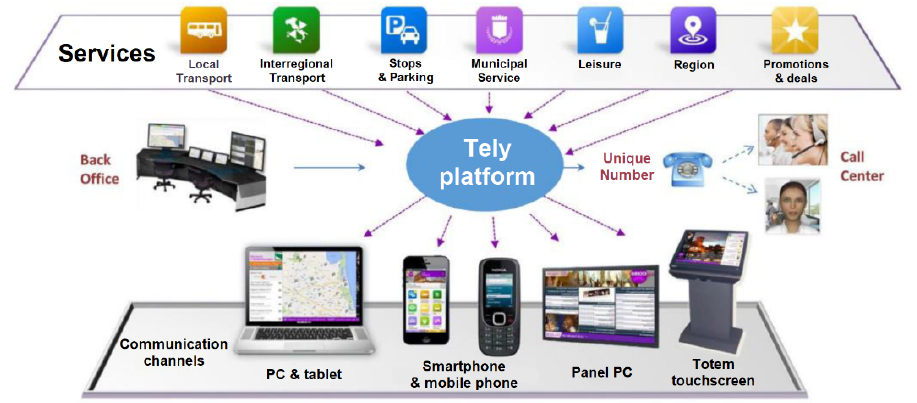
Fig. 1. Channel and service. Source: elaborated from I.T.Svil